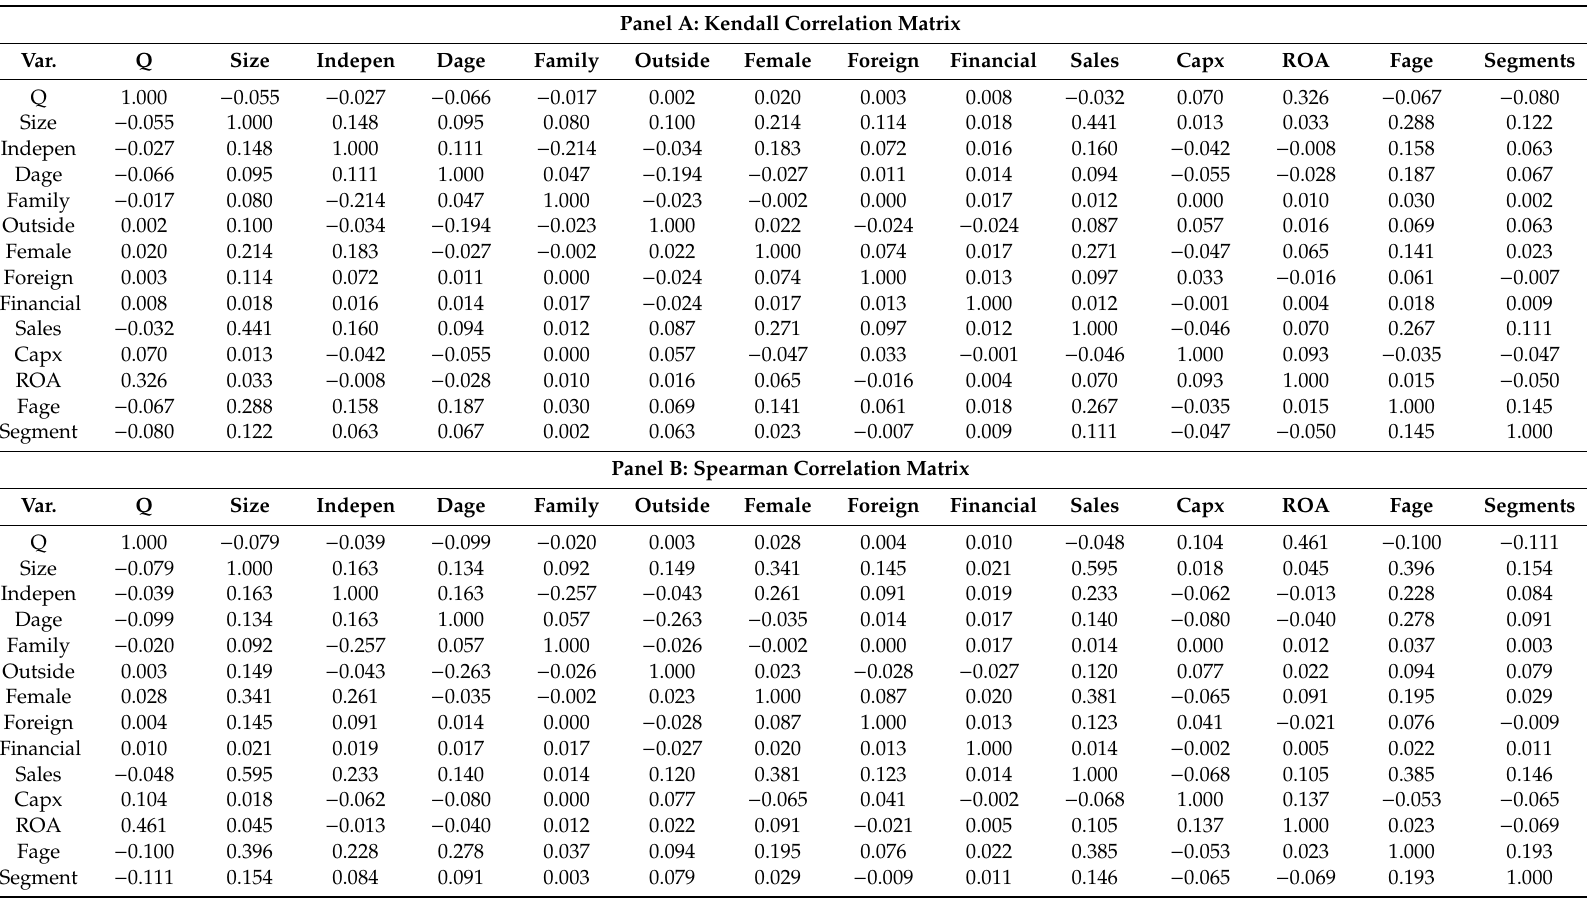
Table A2. Kendall & Spearman Correlation Matrix. Panel A: Kendall Correlation Matrix